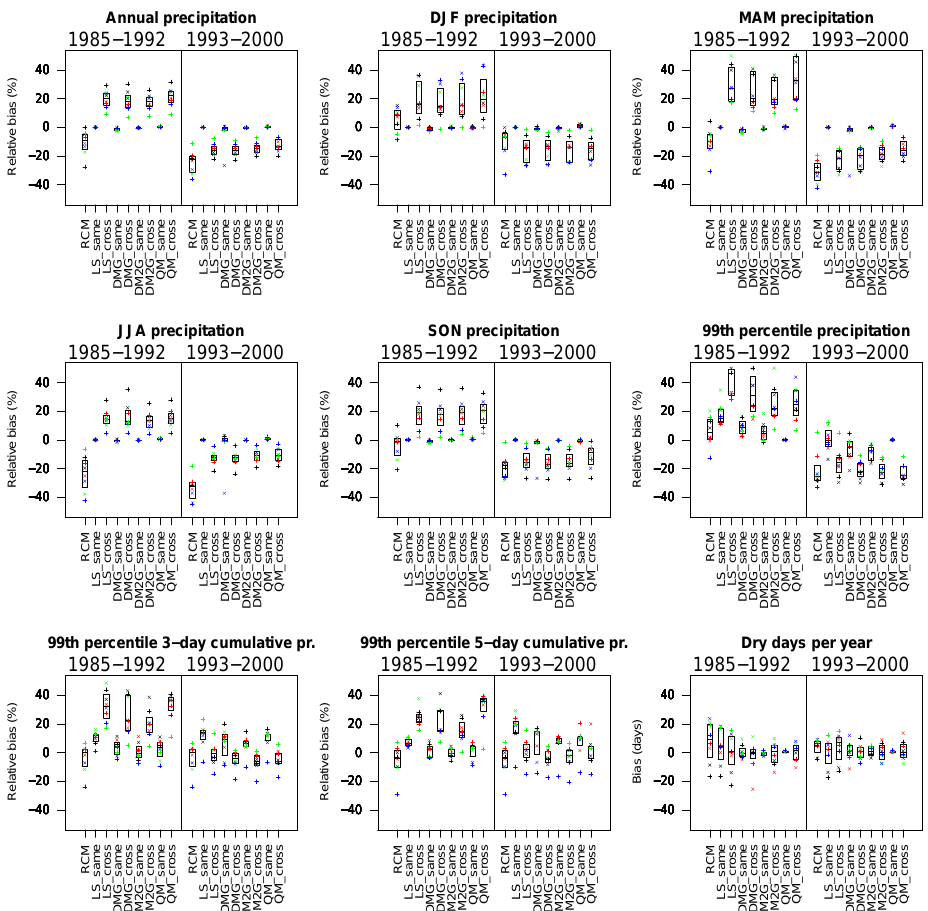
Figure 3. Relative bias of precipitation characteristics, expressed as percentage differences relative to observations between raw RCM and bias corrected RCM precipitation. Each panel displays a different characteristic (title at top of panel) and the percentages were calculated after applying four different bias correction methods (key at bottom) to eight catchments over two periods (1985–1992, left; 1993–2000, right). The bias correction methods were LS, DMG, DM2G and QM (see text), the “_same” suffix denotes calibration and the “_cross” refers to cross-validation. Boxes indicate interquartile range; markers indicate the numbers from each catchment (markers are constrained to the edges of the plotting area if the values exceed the range of plotting); the symbol for each catchment can be found in Fig.